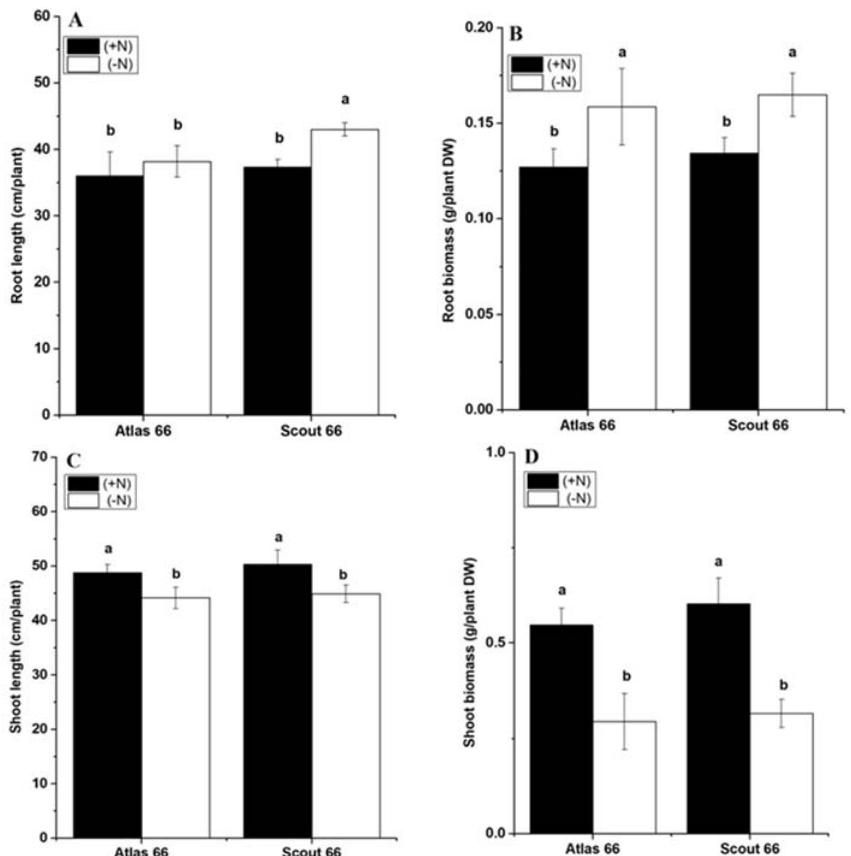
Figure 1. Effect of N deficiency on wheat plant root length ( A ), root biomass ( B ), shoot length ( C ), and shoot biomass ( D ). Wheat plants were transferred from N sufficiency to either N sufficient (2 mM) or deficient (50 µ M) conditions for a defined treatment time. Data presented here were sampled at 14 d from both N levels. Bars represent the mean ± SD ( n = 3). Different small letters indicate statistically significant differences based on LSD tests ( p ≤ 0.05) among the treatments and cultivars.